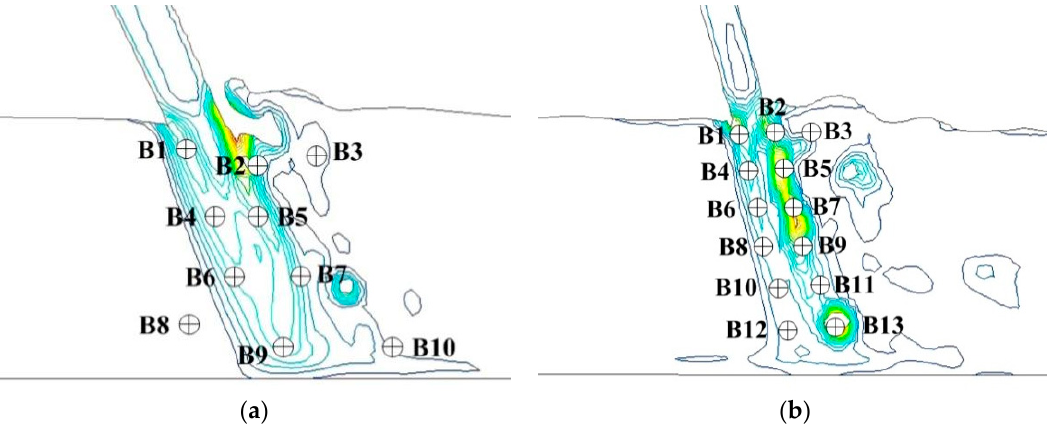
Figure 11. Vorticity monitoring points of mid ‐ line sections of surface and deep orifices: ( a ) Condition 2; ( b ) Condition 6. Table 4. Analyses of vorticity monitoring